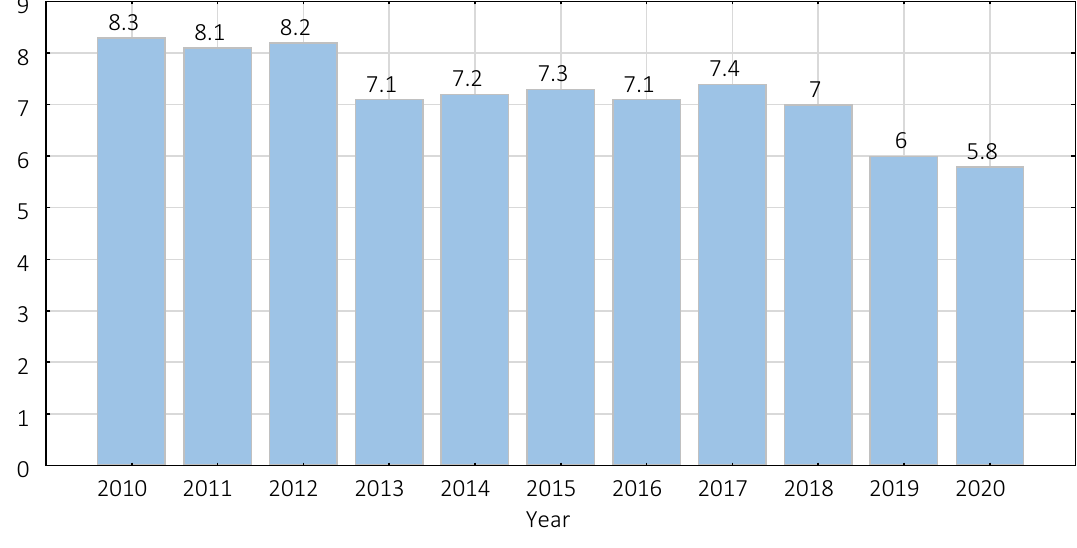
Figure 1. The share of the construction industry in GDP (%)